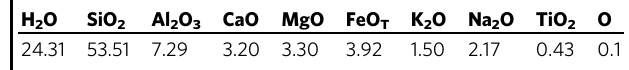
Table 1 Molar proportions of the subducted sediments for thermodynamic